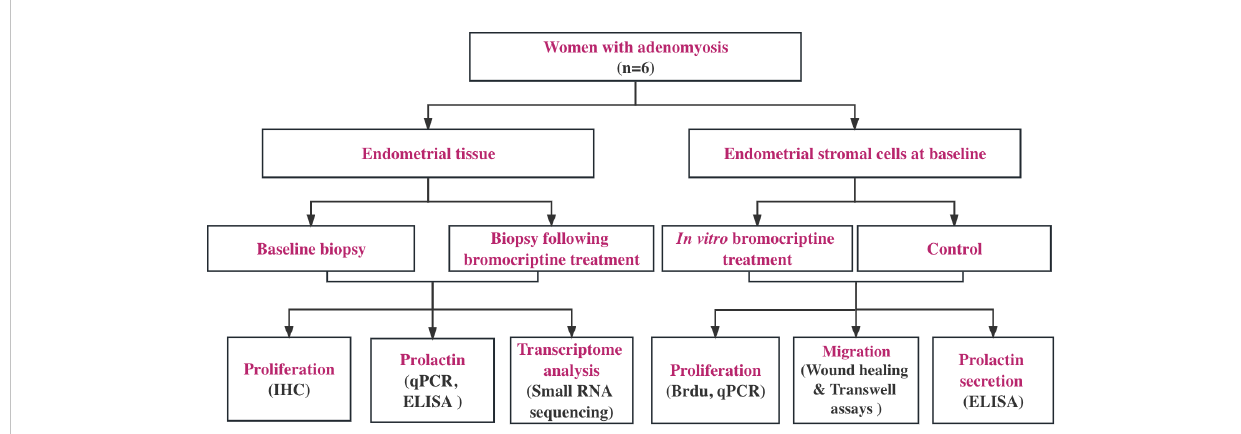
FIGURE 1 Study fl ow chart. Six women with diffuse adenomyosis who were previously enrolled in our pilot study (Andersson et al., 2019) were enrolled for the assessment of cellular and molecular changes induced by vaginal bromocriptine treatment. All the endometrial biopsies were collected during the proliferative phase according to the last menstrual period. The biological action of the bromocriptine was explored in vivo and in vitro separately. Proliferation analysis on tissues at baseline and after treatment was performed using immunohistochemistry (IHC). Local prolactin concentration and mRNA expression level were measured by ELISA and real-time PCR. Small RNA sequencing was performed, and the data were analyzed using bioinformatic software (Partek, R) to understand bromocriptine-induced changes on the transcriptomic level. For in vitro experiment, after